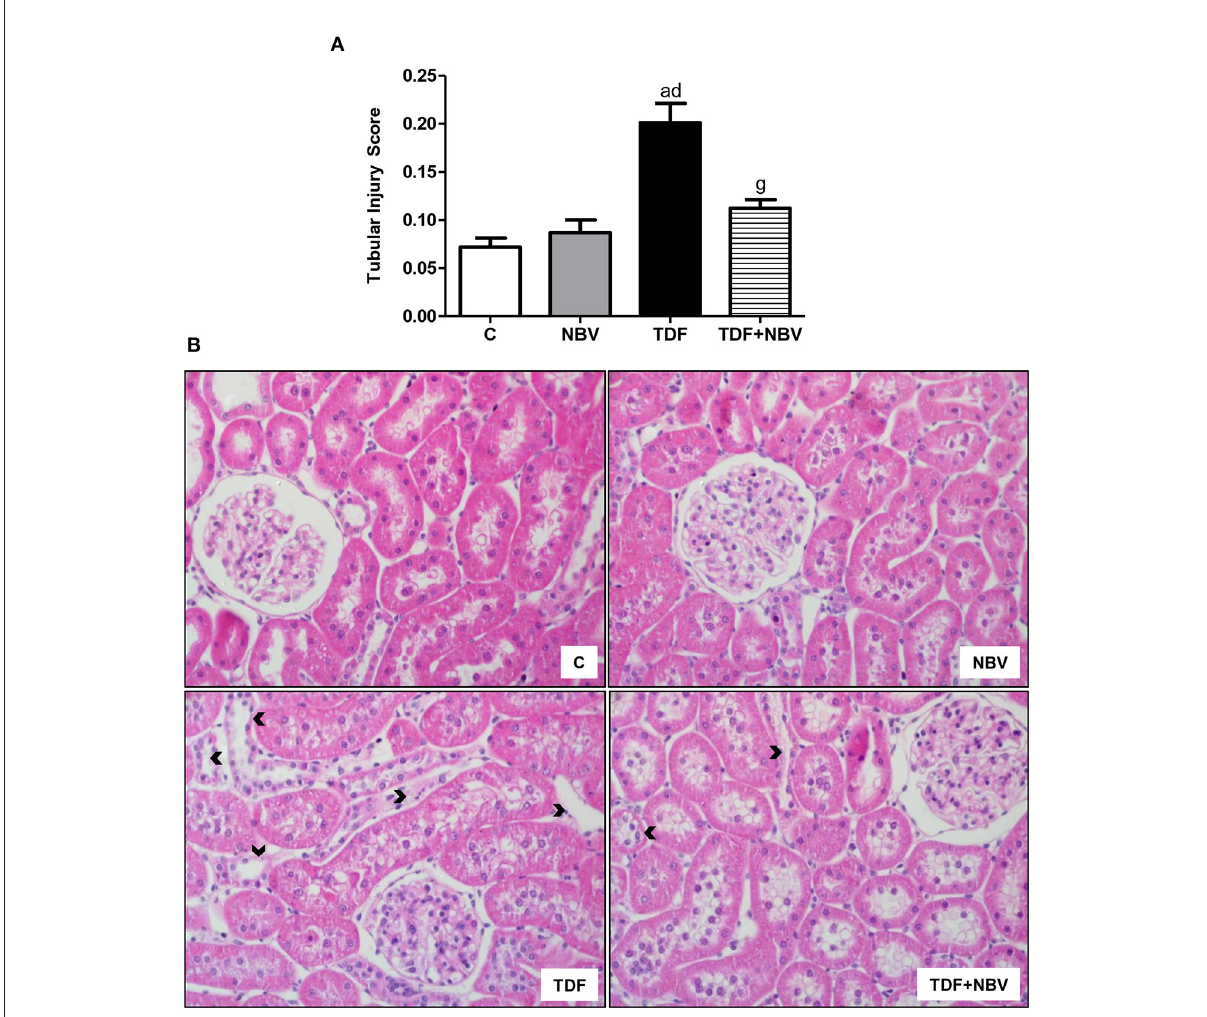
FIGURE3 Tubular injury score in the renal cortex evaluated at the end of the protocol. (A) Bar graph of tubular injury score values. (B) Representative photomicrographs of renal histological changes from a C ( n = 7), NBV ( n = 7), TDF ( n = 8) and TDF + NBV ( n = 8) rat ( × 400). Arrowheads: morphological alterations including tubular cell necrosis, areas of denuded basement membrane, flattening of proximal tubular cells with brush border loss and tubular atrophy or dilatation. Values are means ± SEM. a p < 0.001 vs. C; d p < 0.001 vs. NBV; g p < 0.001 vs. TDF. C, control; NBV, Nebivolol; TDF,